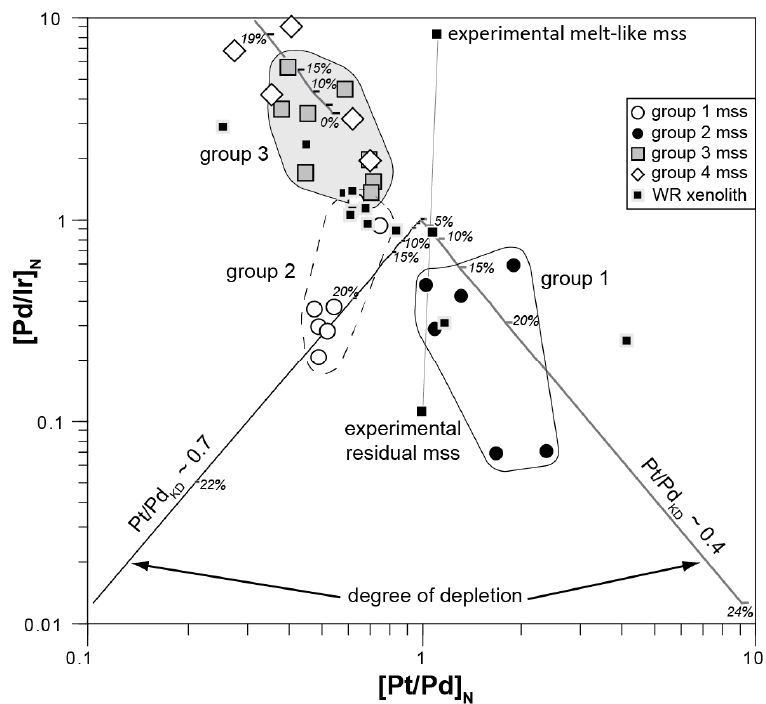
Figure 9. Relationship of [Pt/Pd] N -[Pd/Ir] N with residual mss (group 1, open circles; Group 2, black circles), melt-like mss (Group 4, open diamonds), and mss with unfractionated PGE patterns (Group 3, grey squares) relative to refractory peridotite and melt trends, shown in 5% increments (unless otherwise stated). The Group 1 and 2 mss record >20% melt extraction. For clarity, average data of individual mss are shown. Experimentally derived residual and melt-like mss are also shown [39], they appear to suggest a Pt/Pd KD of ca. 1. However, Group 1 and 2 mss from the Middle Atlas do not correspond with this Pt and Pd partitioning, but would have if Pt/Pd KD is ca. 0.4 and 0.7, respectively. Whole-rock systematics of the Middle Atlas xenoliths [20] are indicated as black